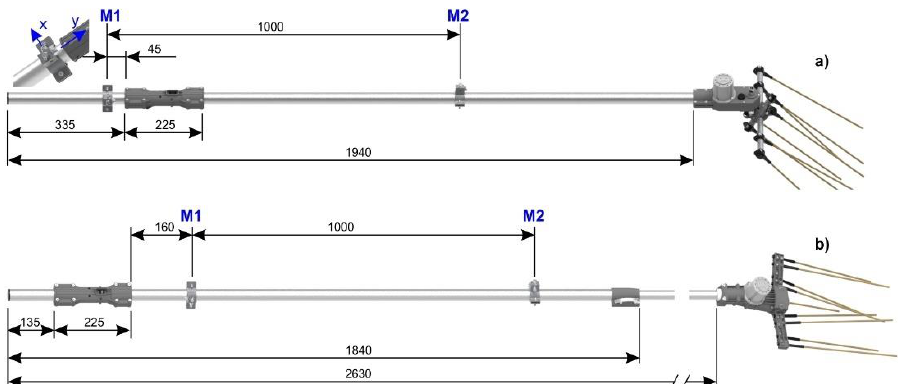
Figure 1. Measuring points of the acceleration during the use of the portable harvesters (sizes in mm). ( a ) Models with fixed length rod; ( b ) Models with telescopic rod.